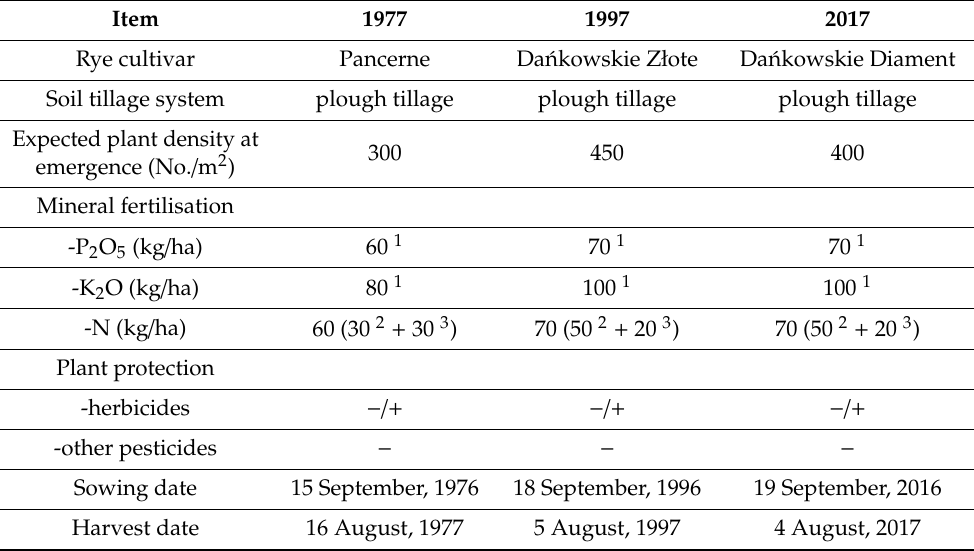
Table 2. Basic agricultural data for winter rye in the years under consideration.